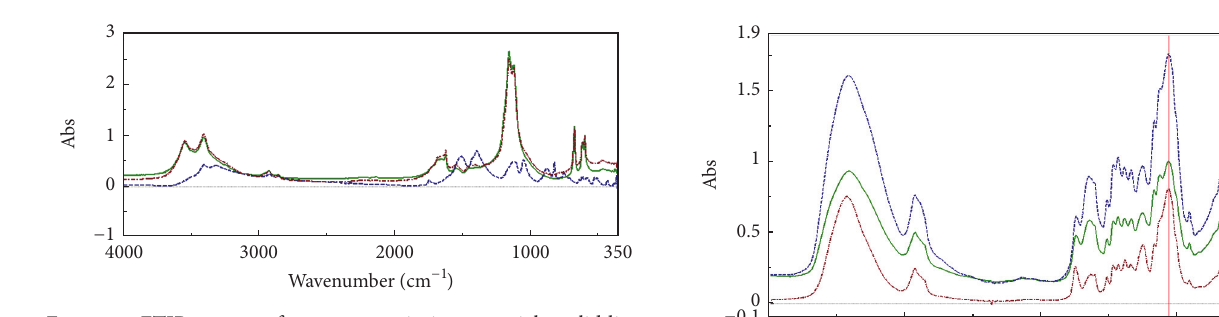
band maximum. Different lignin to cellulose ratios, defined [22] as ( L / C ) 1 = 𝐴 1506 /𝐴 1738 , ( L / C ) 2 = 𝐴 1506 /𝐴 1158 or = 𝐴 /𝐴 ( L / C ) = 𝐴 /𝐴 ( L / C ) 3 1506 895 , and 4 1506 1377 ,